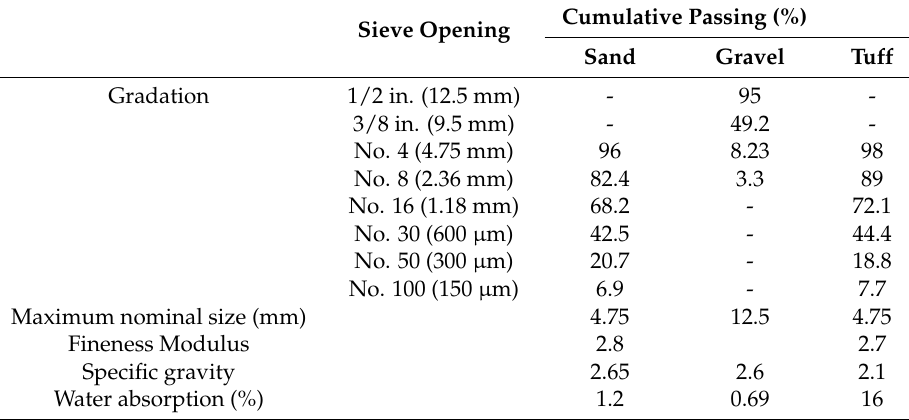
Table 2. Properties of sand, gravel and tuff.